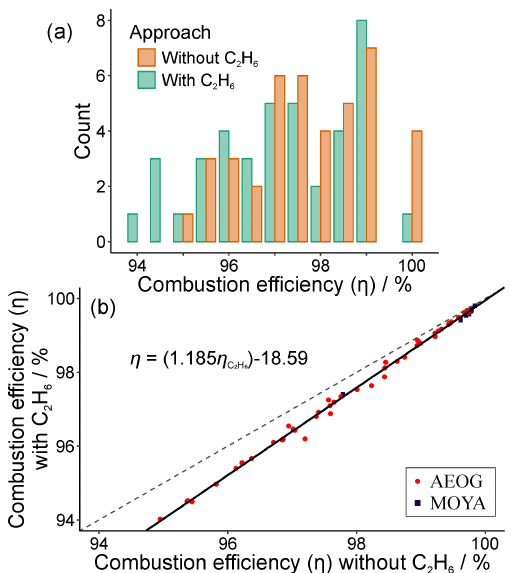
Figure 4. (a) Histogram distribution of combustion efficiencies ( η ) calculated with C 2 H 6 (green; Eq. 3) and without C 2 H 6 (orange; Eq. 2). (b) Linear relationship between combustion efficiencies cal- culated with C 2 H 6 and without C 2 H 6 . The solid black line shows the linear reduced major axis regression, with R 2 = 0 . 996. The dashed black line shows a 1 : 1